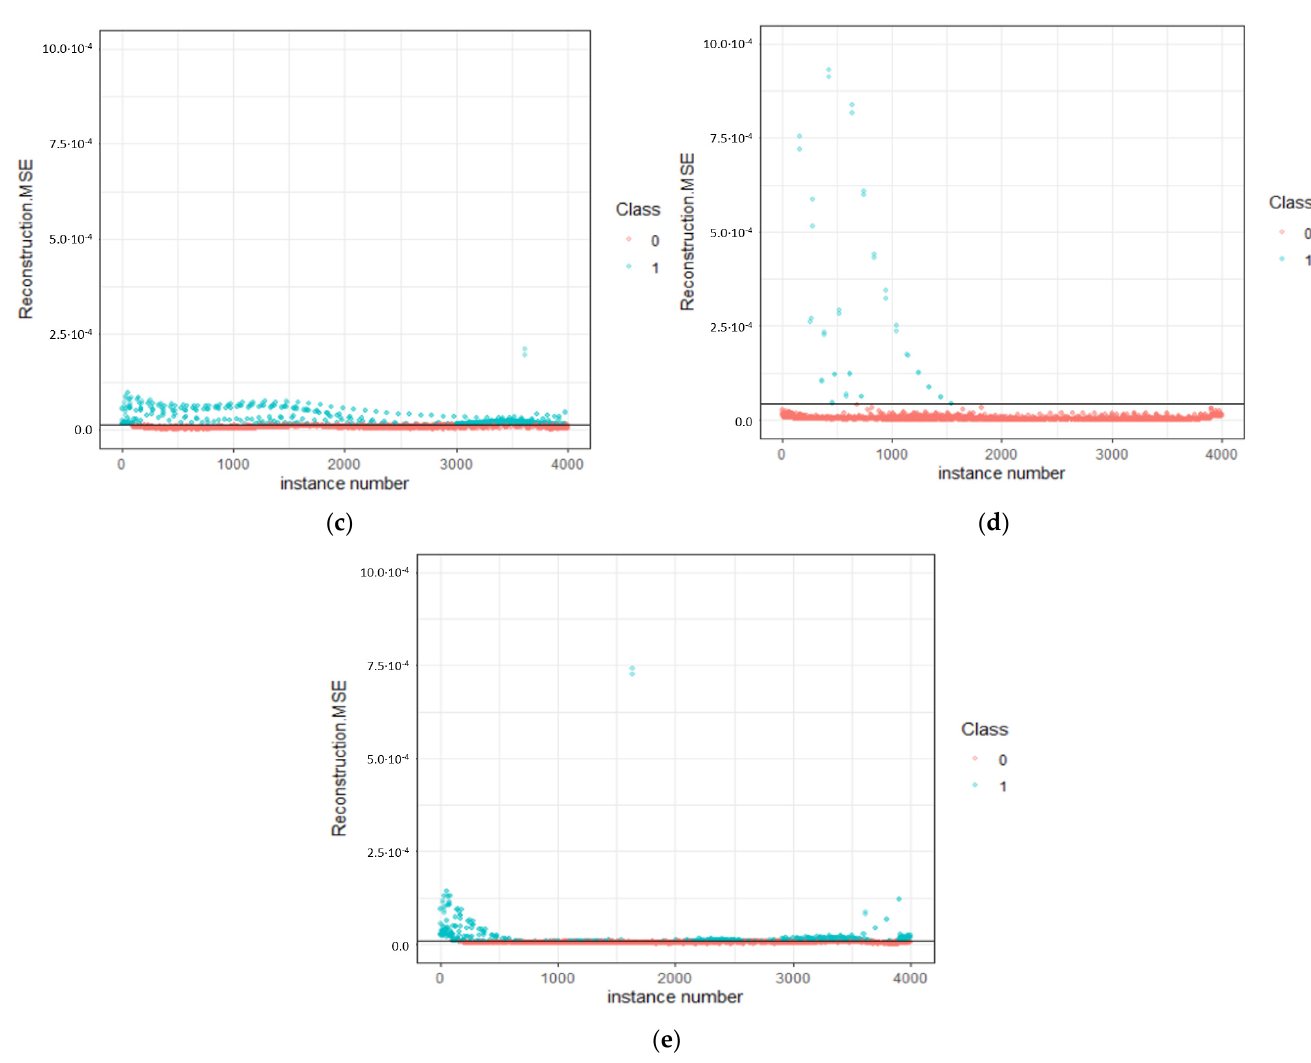
Figure 6. Predictions of ( a ) W-Pristine, ( b ) W-PMAA, ( c ) W-APP on the model trained with pristine data. In ( d , e ), the PMAA and APP specimens have been tested by modeling on the respective pristine-specimen data, respectively. The black line corresponds to reconstruction mean square error baseline for classification. Class 0: normality, 1: anomaly.